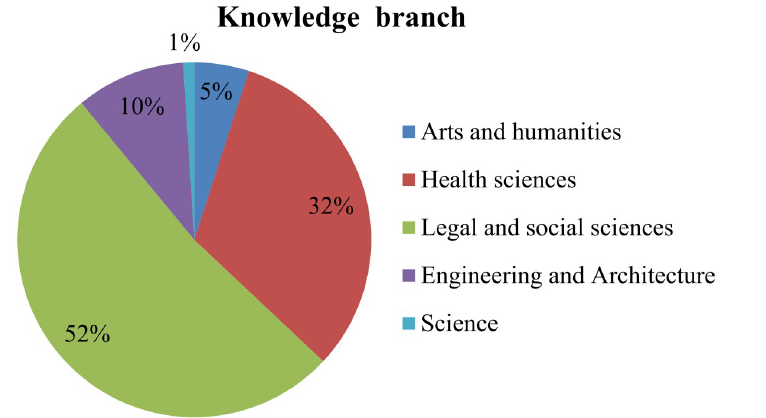
Fig 1. Sample distribution by knowledge